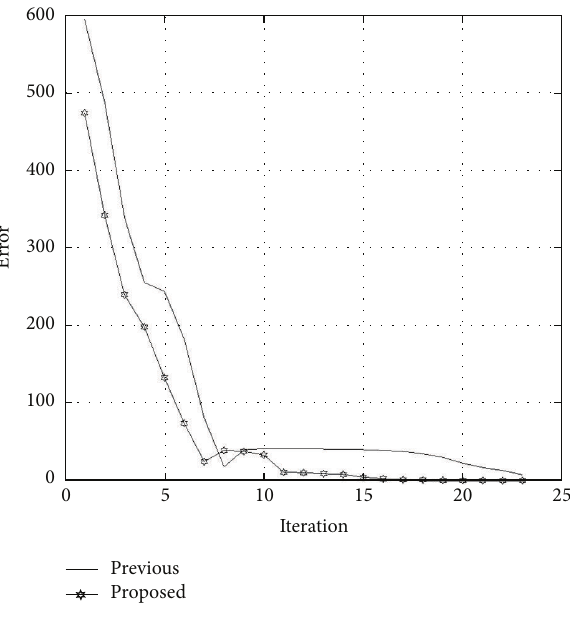
Figure 10: Error convergence comparison.